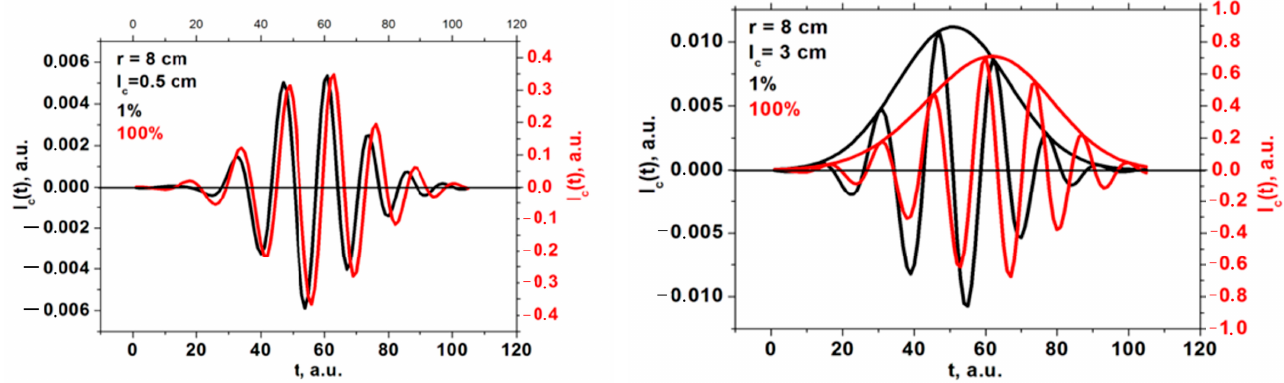
Figure 5. DBS signals for the 48 GHz probing frequency in the case of a circular filament of ( left ) 0.5 cm diameter and ( right ) 3 cm diameter. The black signals correspond to filaments with an amplitude of 1% of density at cutoff of the probing wave, and the red signals correspond to an amplitude of 100%.